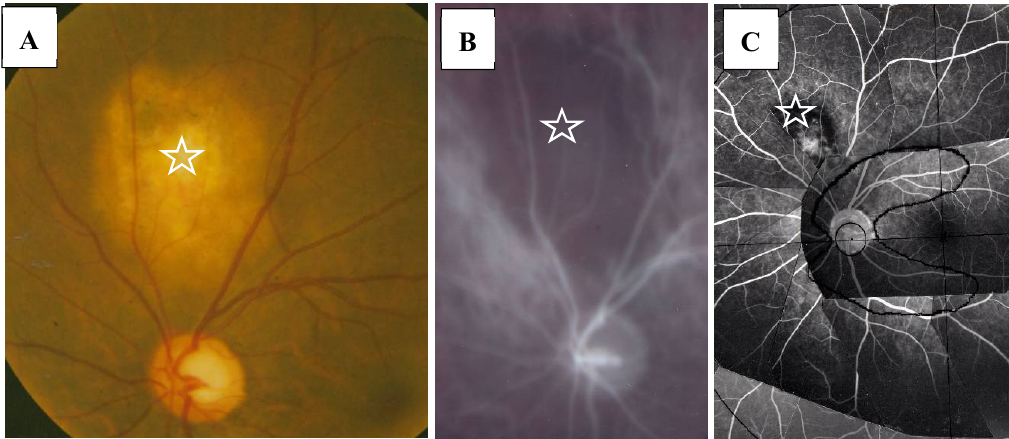
Figure 6. ( A – C ) Images of the right eye of Case 9, a 33-year-old male in Group I with a max IOP of 12 mmHg. Photographs of the fundus ( A ), indocyanine green angiography ( B ), and FFA on a mounted transparent sheet with different zones ( C ). Giant nodule located in the choroid (stars in A – C ) showing no filling of indocyanine green ( B ). Fluorescein leakage can be seen at the center of the giant nodule ( C ).